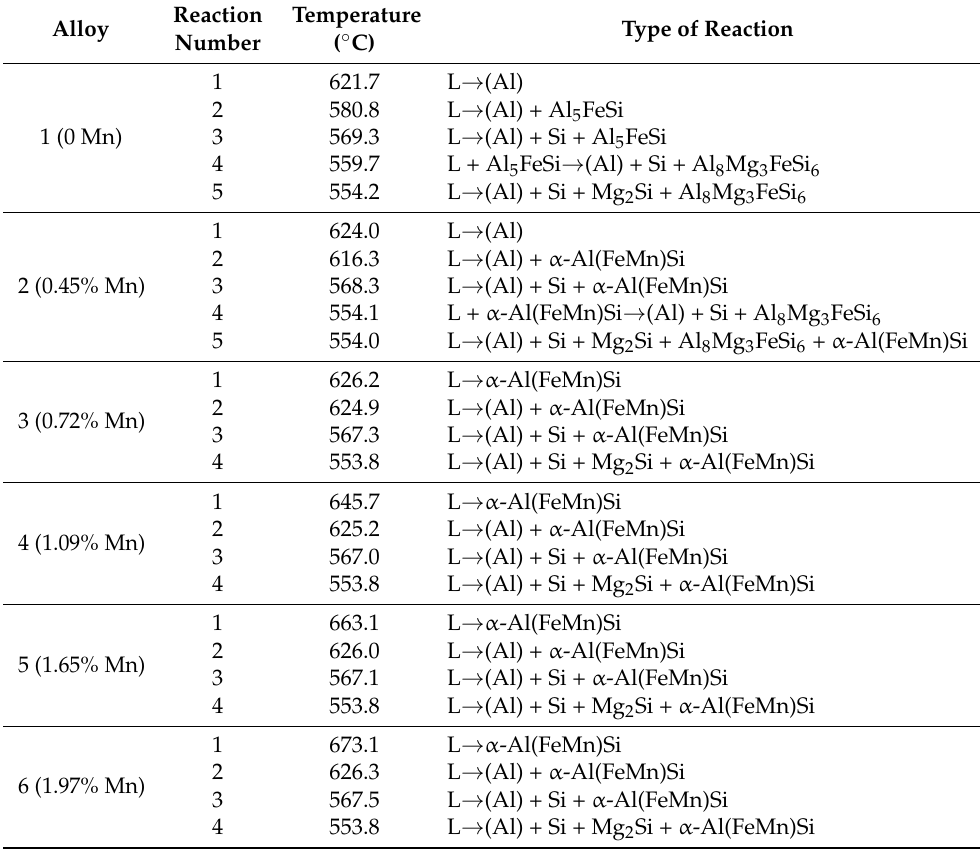
Table 3. Main reactions observed from the thermal analysis diagrams of the experimental